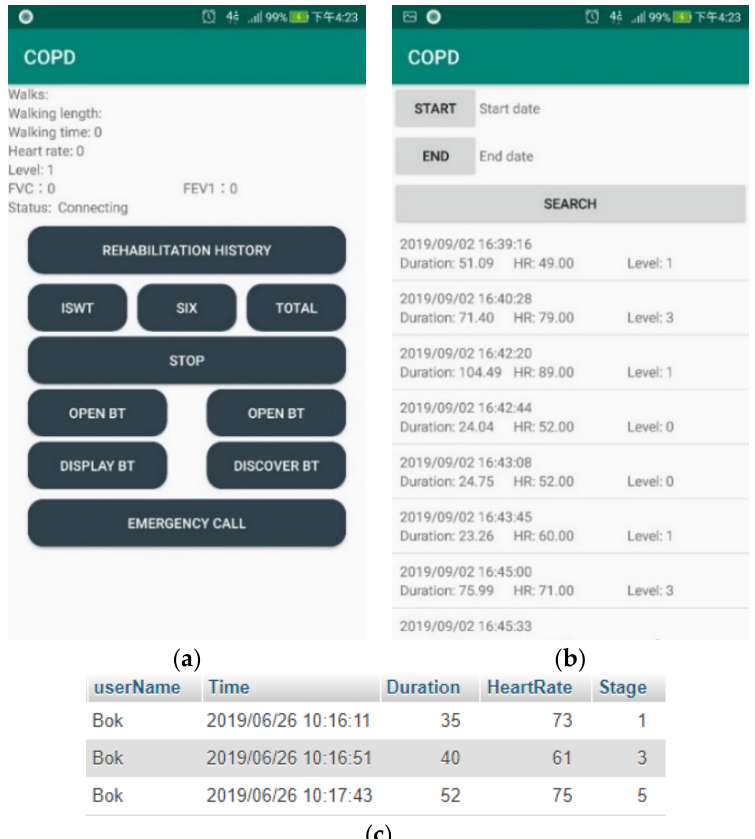
Figure 19. ( a ) The main control screen; ( b ) The rehabilitation history; ( c ) The pulmonary rehabilita- tion history (SQL).